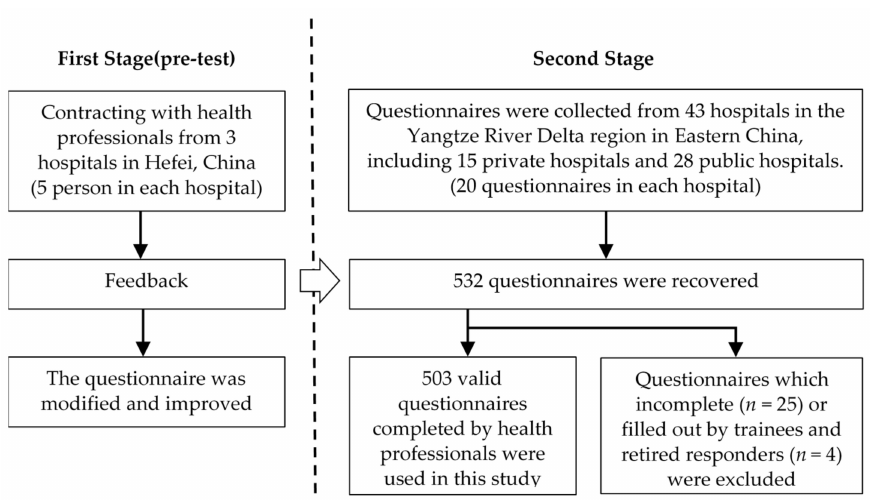
Figure 2. The process of data